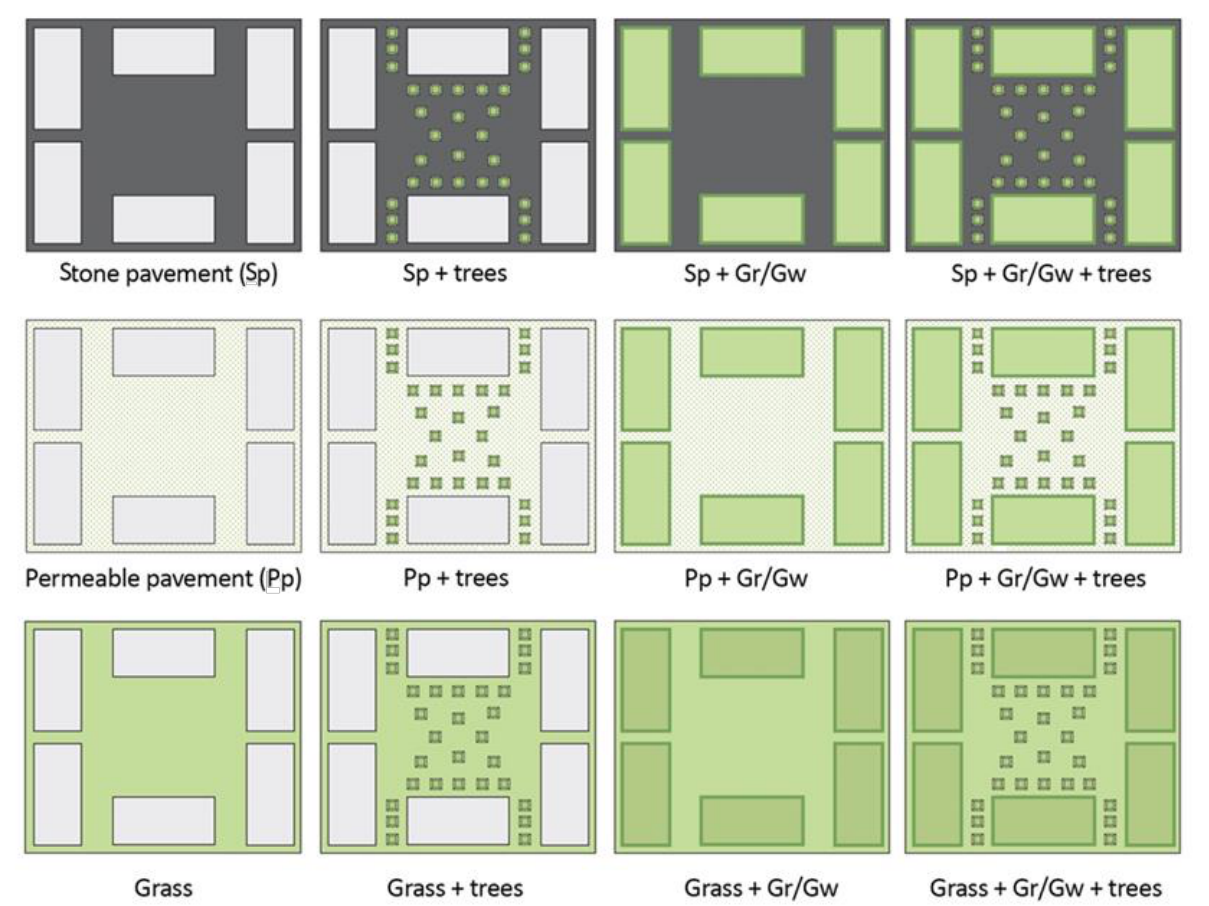
Figure 3. Schematic representation of the 12 scenarios generated in the workflow.